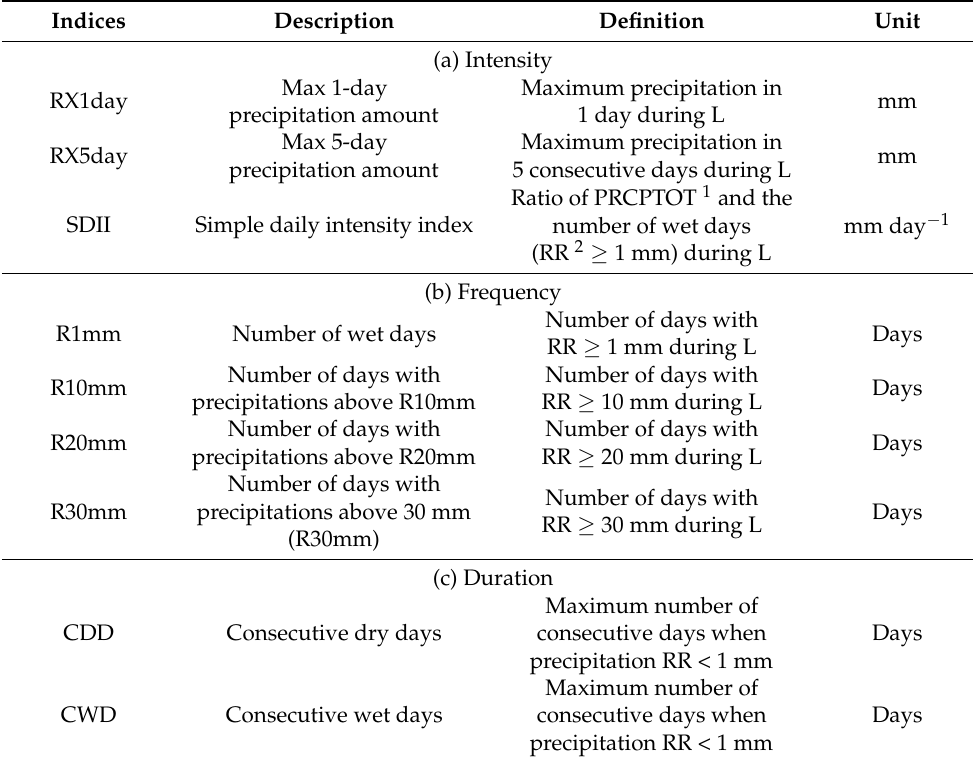
Table 1. Extreme daily precipitation indices (http://etccdi.pacificclimate.org/list_27_indices.shtml, accessed 13 January